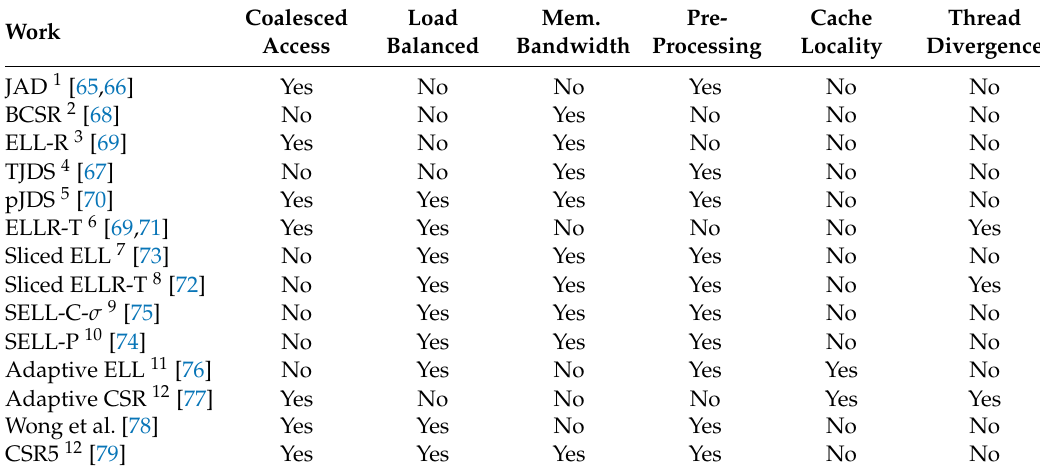
Table 1. Comparative analysis of various discussed features in discussed sparse matrix-vector (SpMV) multiplication